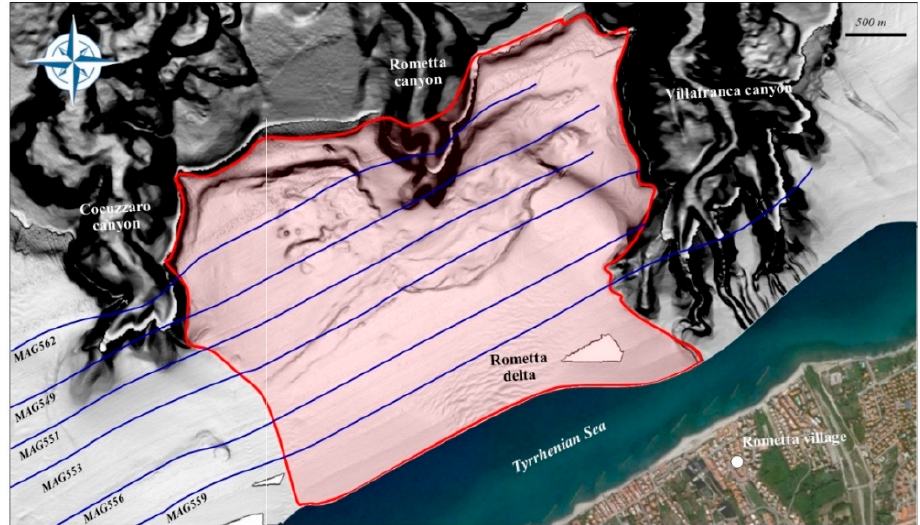
Figure 2. Overlapping of the dataset analyzed for the geomorphological reconstruction of north- eastern Sicilian offshore: the bathymetric data (multibeam) and the traces of seismic profiles (CHIRP).